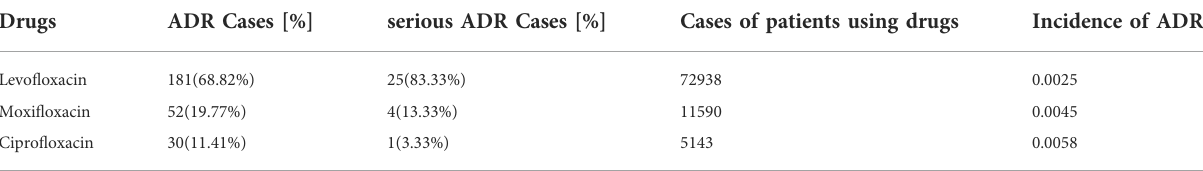
TABLE 3 Adverse drug reactions (ADR) involving organs or systems and their main clinical